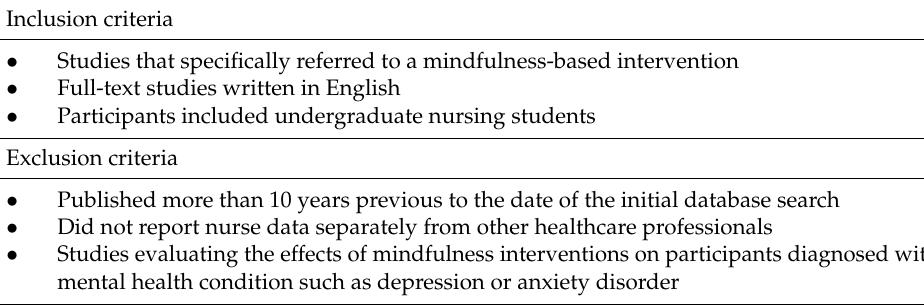
Figure 1. Search strategy flow diagram. Table 1. Table outlining inclusion and exclusion